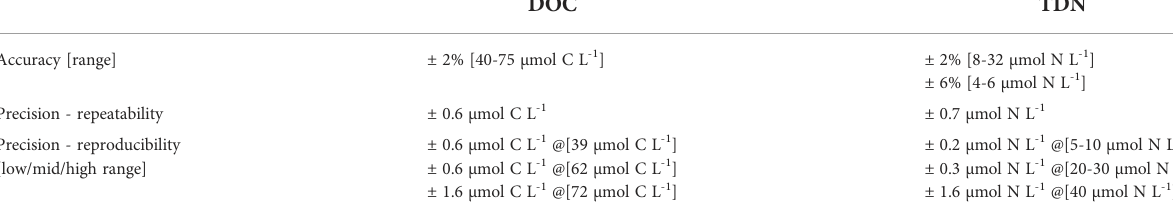
TABLE 2 Summary of analytical quality limits for analysis of DOC and TDN in seawater using the HTC method.